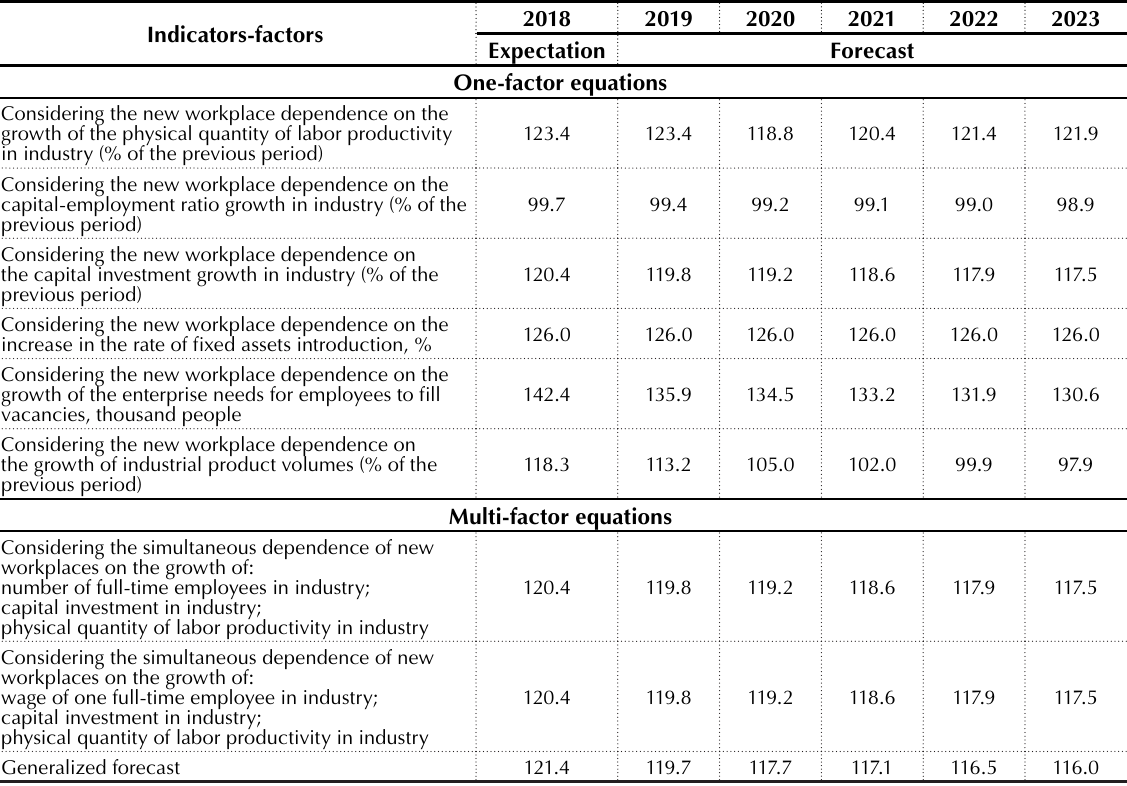
Table 6. Forecast of growth (slowdown) rate of new workplaces in industry (as a whole) for 2019–2023 Source: Calculated by the authors based on the model developed.